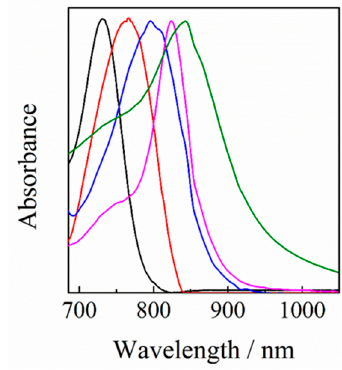
Figure 6. Normalized UV-visible absorption spectra of Y6 in a chlorobenzene solution (black line), Y6 neat film (green line), Y6 doped in RRa-P3HT (red line), PBDB-T (blue line), and polystyrene (PS) (purple line) films with a weight fraction of 5 wt %. The absorption spectra of Y6 in di ff erent polymer films were corrected by subtracting the absorption of polymer neat